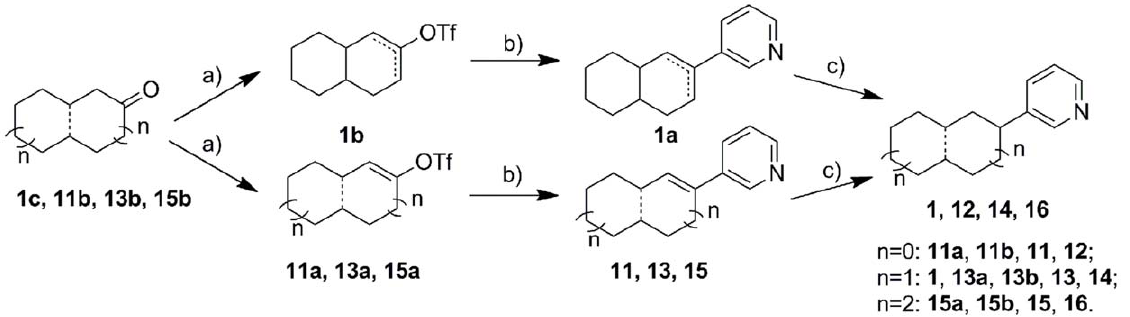
Figure 4. Reagents and conditions. a) Method A: Tf 2 O, CH 2 Cl 2 , 2,6-di-tert-butyl-4-methylpyridine, 2 h; b) Method B: Pd(PPh 3 ) 4 , pyridine-3-boronic acid, Na 2 CO 3 , DME, H 2 O, 90 u C, 2 h; c) Method C: 5% Pd/C, MeOH, H 2 , RT, 2 d.